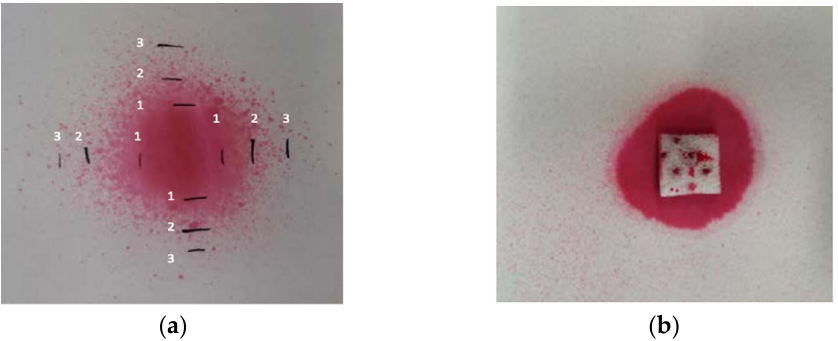
Figure 2. Distribution of an aqueous solution of Allura red AC observed when performing ( a ) 1 spray with different heights such as 2 cm (line 1), 3.3 cm (line 2), and 4.5 cm (line 3); ( b ) 3 sprays at previously optimized fixed height (4.7